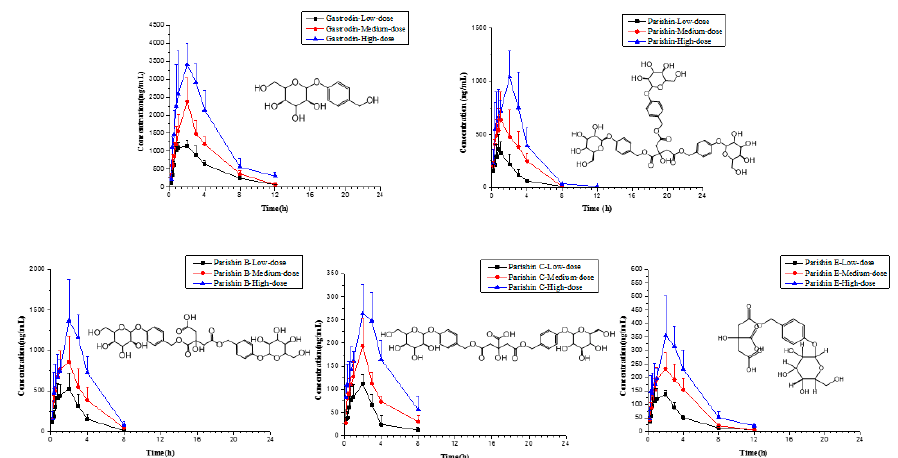
Figure 2. Mean plasma concentration-time profile of five compounds in beagle dog after intragastric administration of low dose, medium dose and high dose tall Gastrodia capsules ( n = 5). Gastrodin was detected in beagle dog plasma 10 min after intragastric administration of capsules at all three dosage levels. For low, medium and high doses, retention time of the maximum plasma concentration (T max ) was reached at 1.10, 1.75 and 2.00 h, respectively. These results were similar to